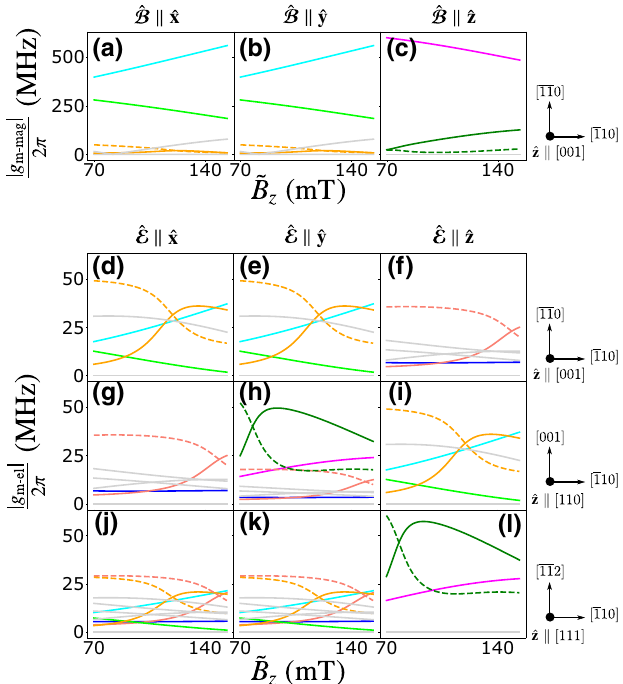
FIG. 13. Magnetic and electric coupling strengths of magnon modes in the low-temperature SkX. (a)–(c) Magnetic coupling | /( 2 π) and (d)–(l) electric coupling constant constant | g ( n ) m-mag | /( 2 π) of the lowest 18 energy eigenstates, obtained at | g ( n ) m-el ˜ E n / (cid:2) , and η = 0.1 with Eqs. (G3) and (G4). D / J = 0.5, (cid:3) = ˜ E n and The rescaled energy eigenvalues of the n th magnon mode magnetic field ˜ B z are defined in Eqs. (B1a) and (B1b), respec- tively. For typical parameters of V = 300 mm 3 [44] and (cid:3) = 4 GHz for the CCW mode, the maximum amplitudes of magnetic and electric fields are B 0 = 2.4 pT and E 0 = 0.7 mV m − 1 . In ˆ B ˆ E each row, the directions of electromagnetic fields and are aligned parallel to the ˆ x , ˆ y , and ˆ z axes (from left to right), where ˆ z is parallel to the applied magnetic field and the corresponding crystalline axes are indicated to the right. The color code is the same as in Fig.